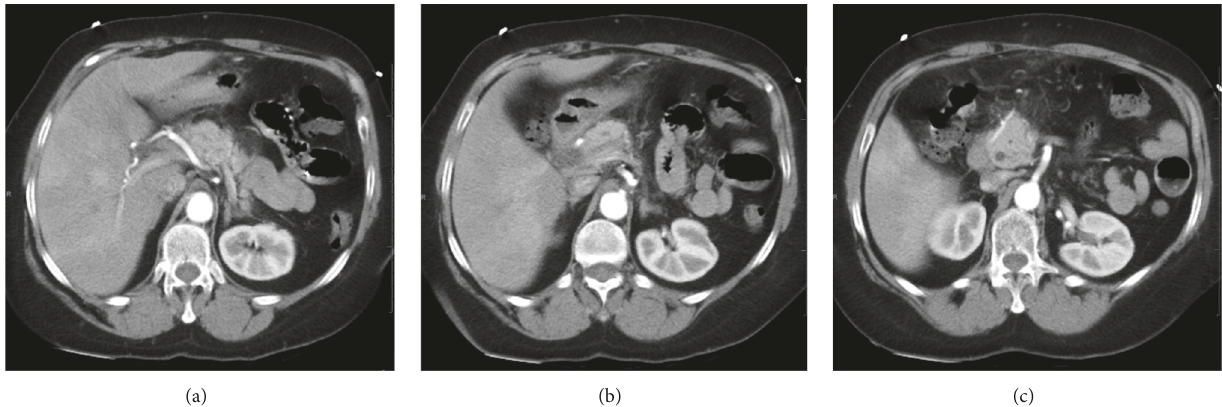
Figure 2: Computed tomography angiography of the chest and abdomen. Contiguous axial images demonstrate mild hazy linear increased attenuation adjacent to the neck (a) and head ((b) and (c)) of the pancreas, representing inflammatory